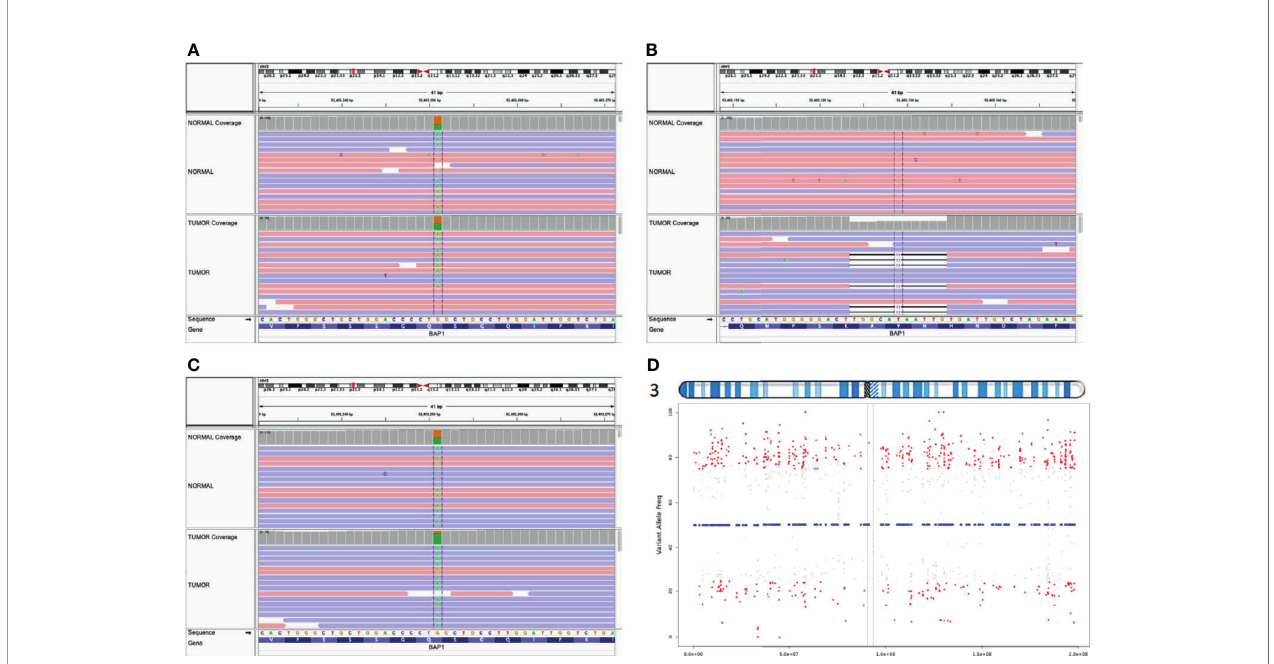
FIGURE 4 | Biallelic inactivation of BAP1 by differing mechanisms. Aligned sequence data from Patient A show the pathogenic BAP1 variant is heterozygous in the germline (top track) and tumor (bottom track) (A) ; the second hit is a somatic frameshift mutation (B) . In contrast, aligned sequence data from Patient B (C) show the germline variant approaching homozygosity in the tumor (D) . VarScan tumor allele frequency plot for heterozygous germline variants on chromosome 3 of Patient B indicates chromosome-level LOH across chromosome